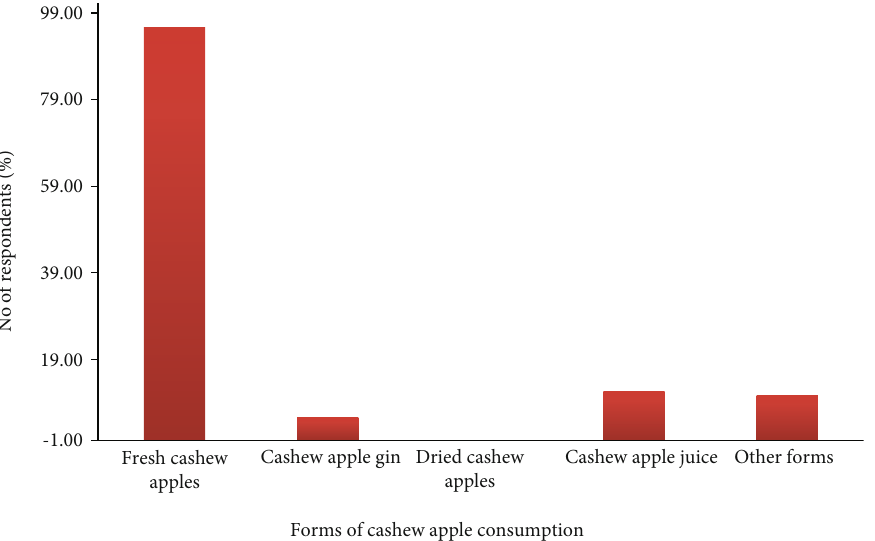
Figure 6: Forms of cashew apple consumption by cashew stakeholders. Note: others refer to responses outside the thematic areas.